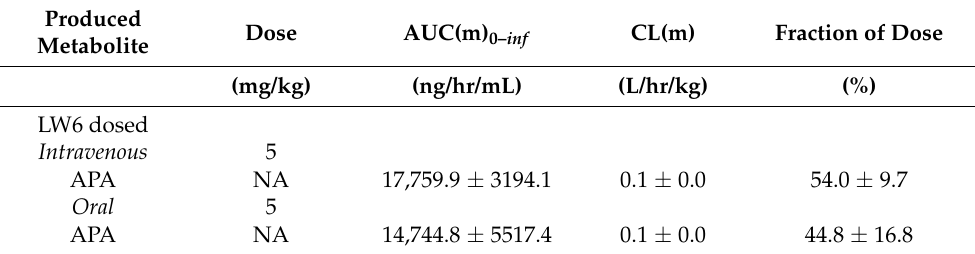
Table 4. Estimated fraction of dose available systemically as APA following a single administration of LW6 in